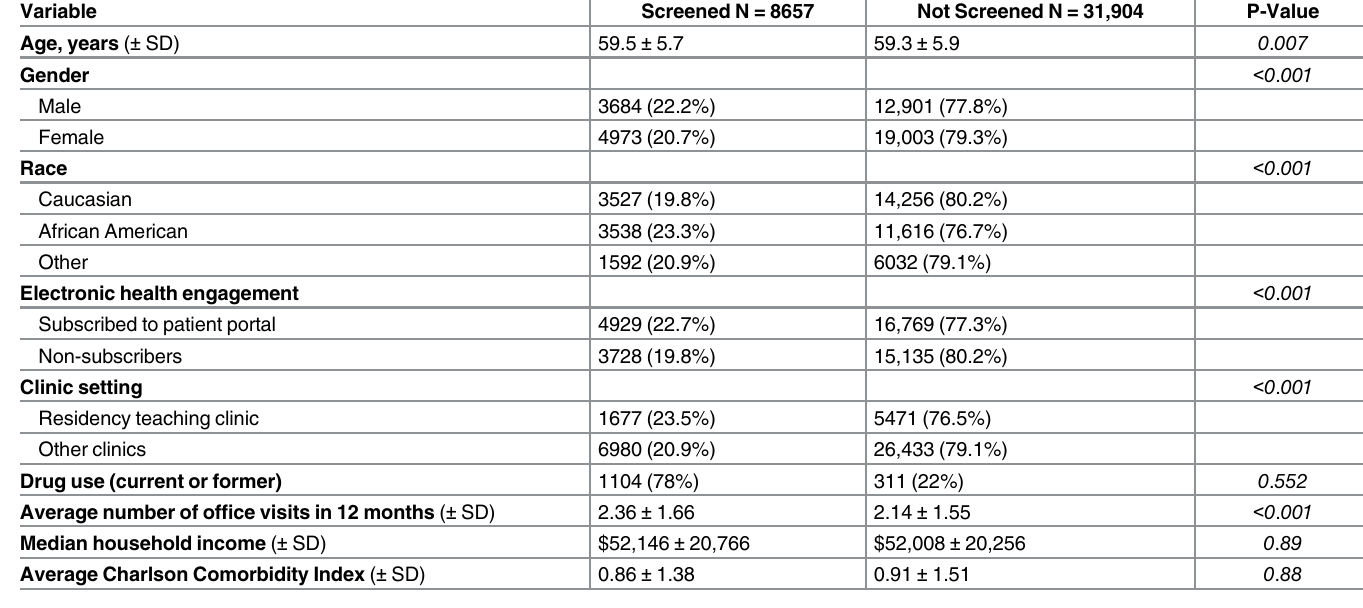
Table 2. Univariate analysis comparing screened versus not